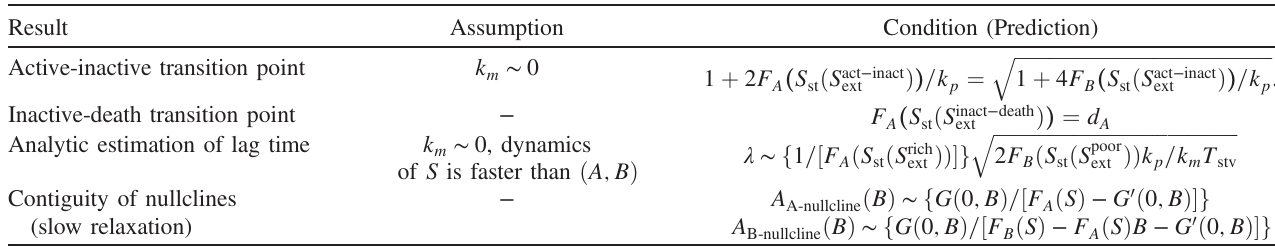
TABLE I. Predictions and